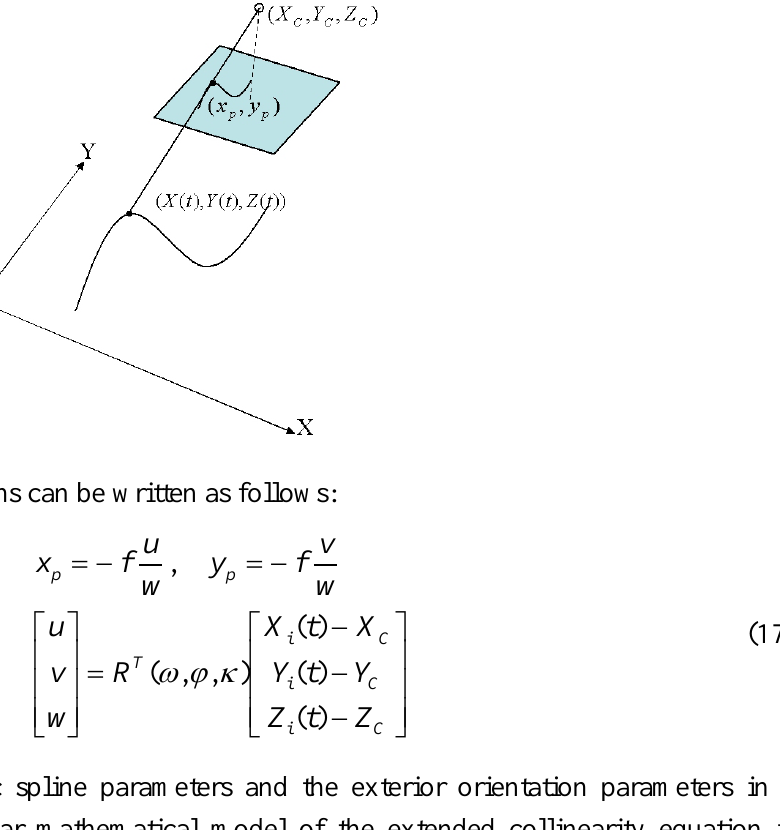
Figure 2. The projection of a point on a